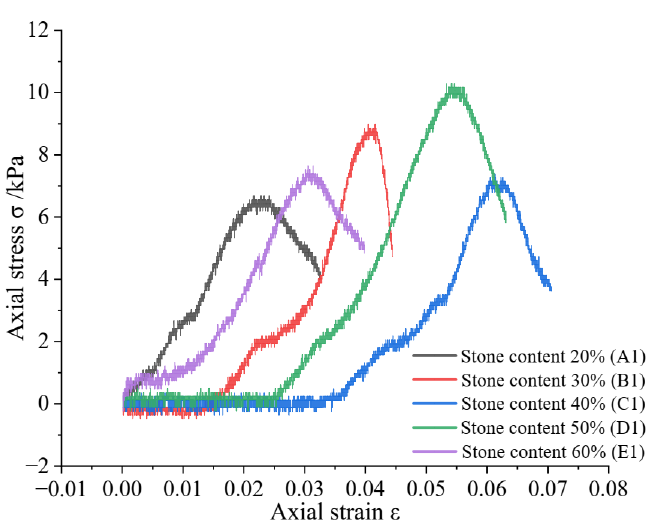
Figure 3. Stress–strain curve of soil–rock mixture stone with particle sizes of 0.2–0.4